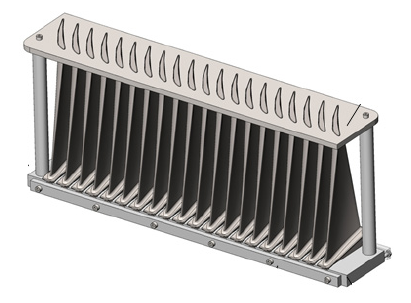
Figure 3. General view of the multi-seat